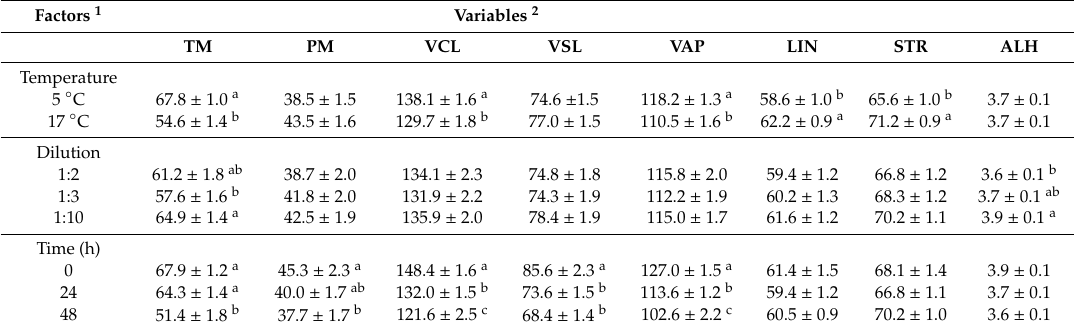
E ff ect of semen liquid preservation at di ff erent temperatures, durations and sperm concentrations on sperm motility and